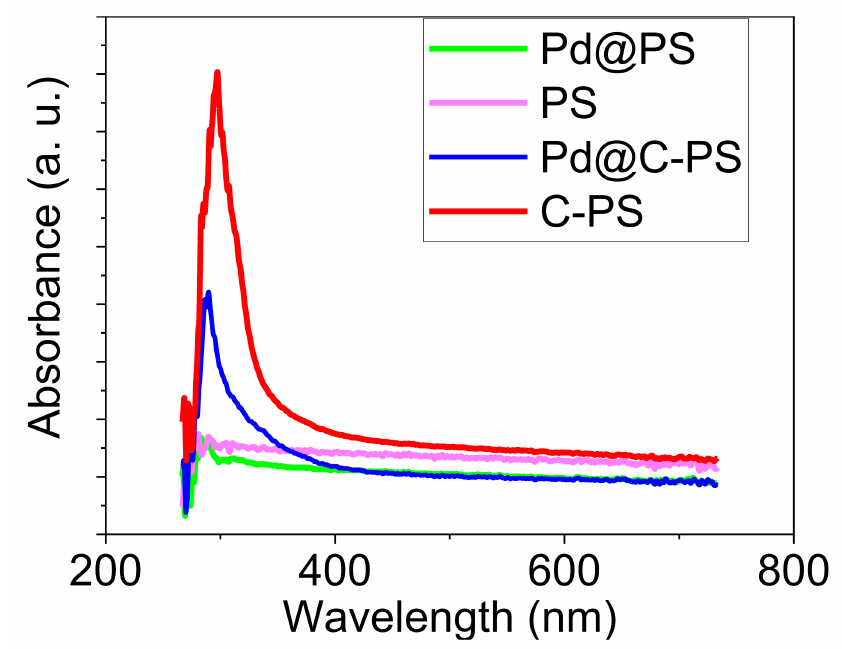
Figure 1. UV–Vis spectra of PS, C–PS, Pd@PS, and Pd@C–PS. A Fourier-transform infrared (FT-IR) spectrum was prepared to characterize the functional groups of Pd@C–PS (Figure 2). The structure of the composite was approved based on the absorption bands noted at 3439, 1122, 1033, and 779 cm − 1 for OH, Si–O–Si, Si–OH, and Si–O bonds, respectively. The appearance of two peaks at 2973 and 440 cm − 1 confirmed the existence of carbon atoms in the composite structure, and these peaks were assigned to CH and SiC bonds, respectively [46].